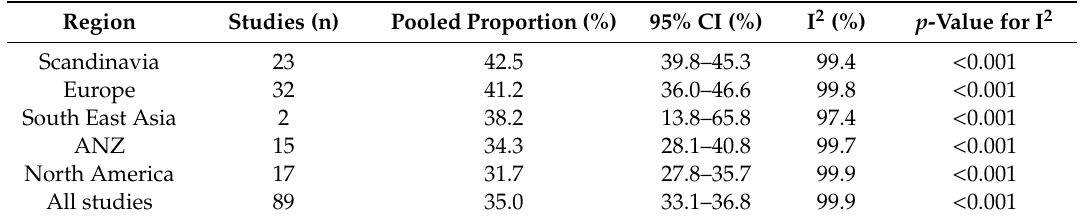
Table 2. Pooled proportion of any CNS medicine use according to geographical location. Table 1. Pooled proportion of any CNS medicine use according to geographical location.